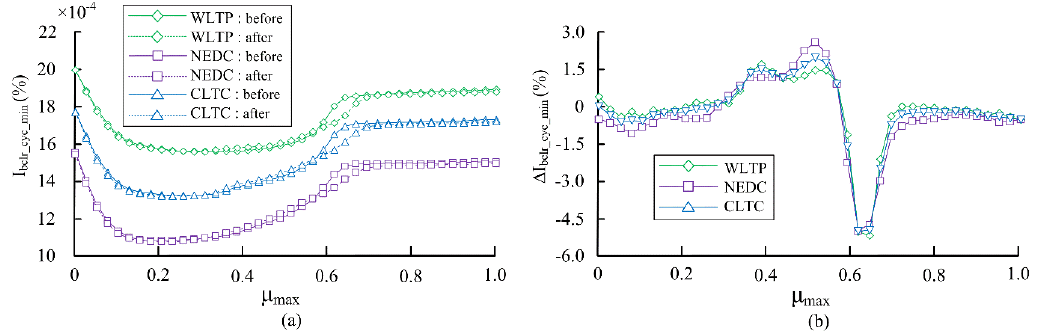
Figure 16. Optimization results in three driving cycles before and after optimization: ( a ) I bclr_cyc and ( b )